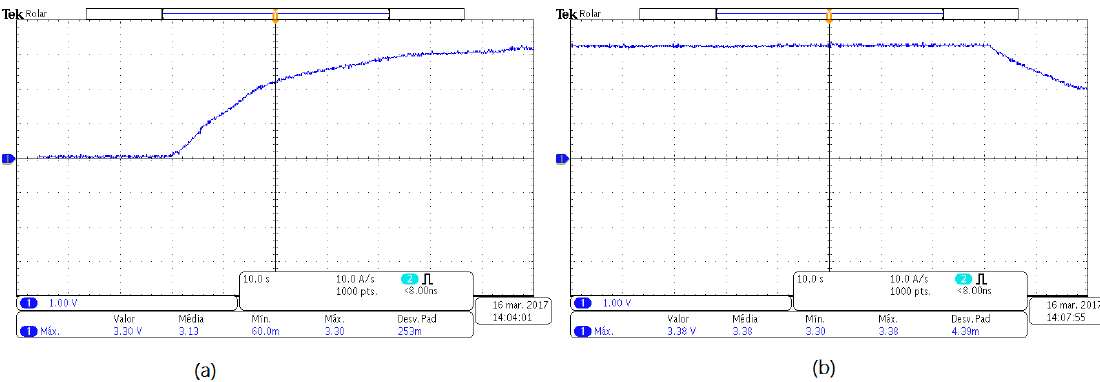
Figure 15. ( a ) Stabilized voltage; ( b ) Voltage after stopping transmitting.